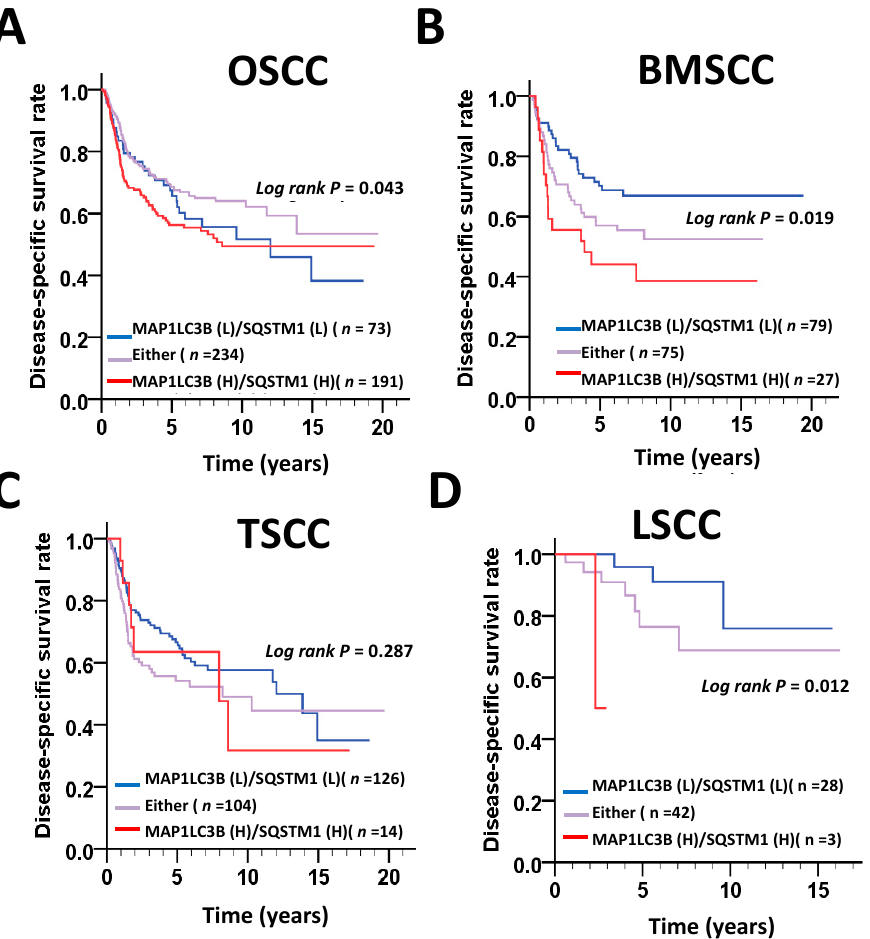
Figure 3. DSS survival curves for the coexpression of MAP1LC3B and SQSTM1 in patients with different subsites of OSCC. DSS survival curves for the coexpression of MAP1LC3 and SQSTM1 are shown for OSCC ( A ) and three main subsites, BMSCC ( B ), TSCC ( C ) and LSCC ( D ). The cutoff values for high or low coexpression of MAP1LC3B and SQSTM1 in tumor tissues were based on the receiver operating characteristic (ROC) curve. Table 4. Correlation coefficients ( r ) between MAP1LC3B and SQSTM1 in OSCC.